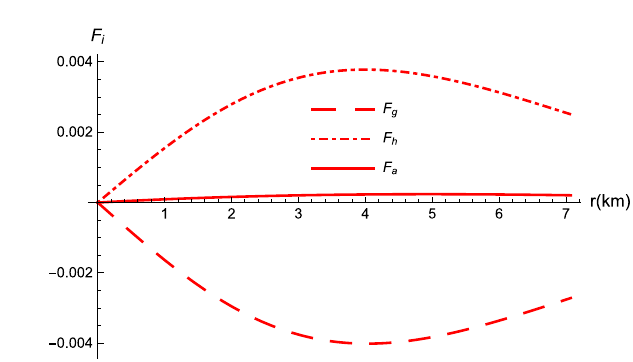
Fig. 13 Energy condition